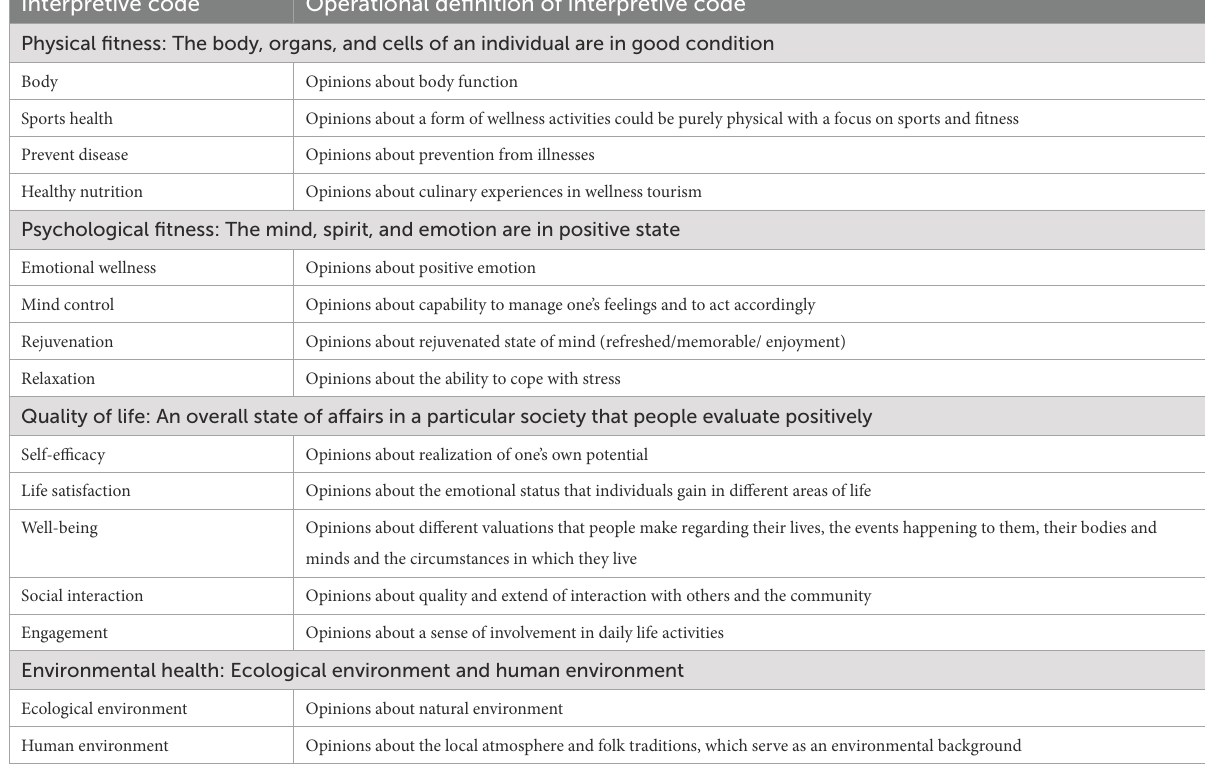
TABLE 2 Interpretive codes under emergent